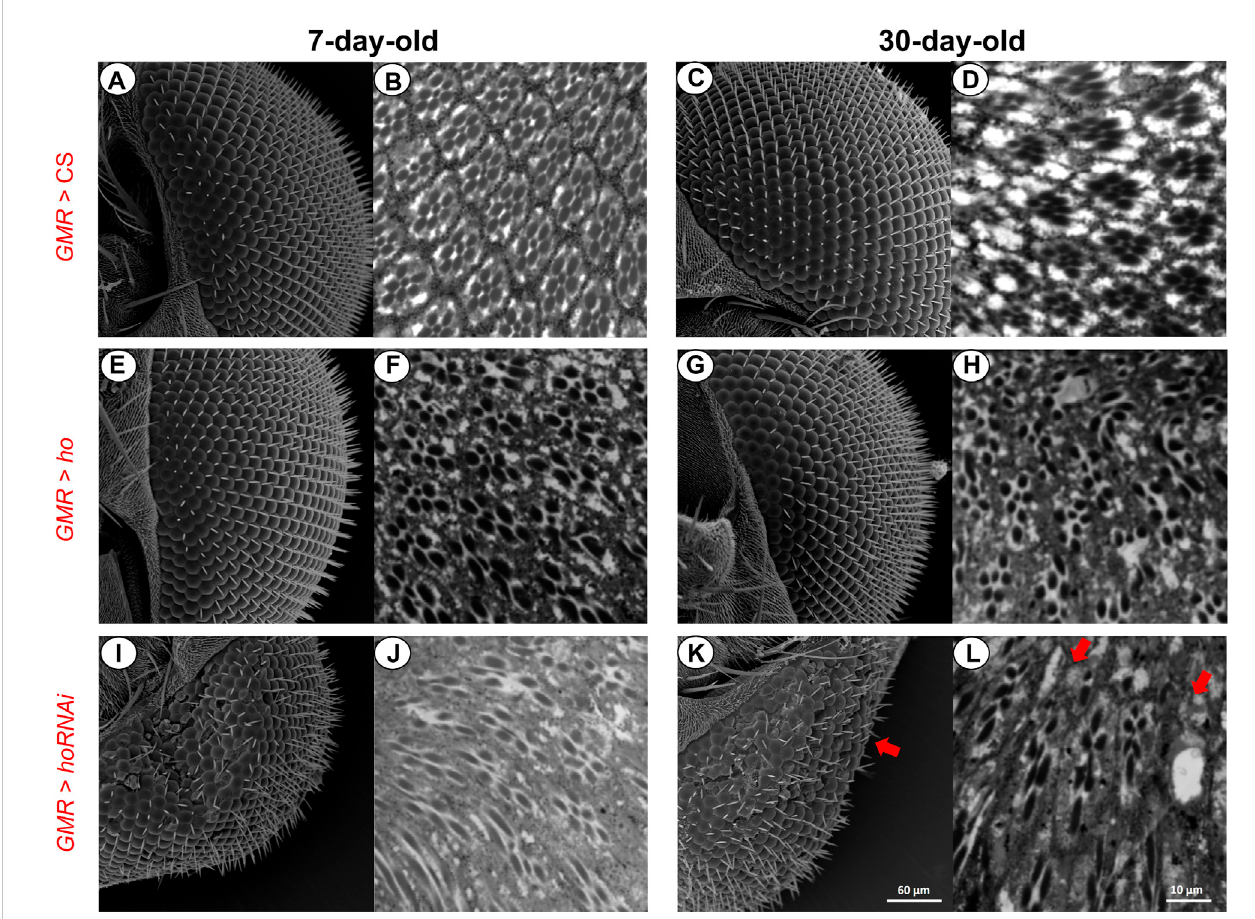
FIGURE 5 Retina photoreceptors were affected when the ho expression levels were changed (by overexpression or silencing) in the retina. Under normal conditions (A – D) , both ommatidia did not show any structural changes even with aging. After partially suppressing ho expression (E – H) , the eye morphology was changed and ommatidia were distorted regardless of age. Upregulation of ho in the retina photoreceptors did not produce any structural changes in the eye morphology (I and K) but in the proximal retina, degeneration was observed (J and L)